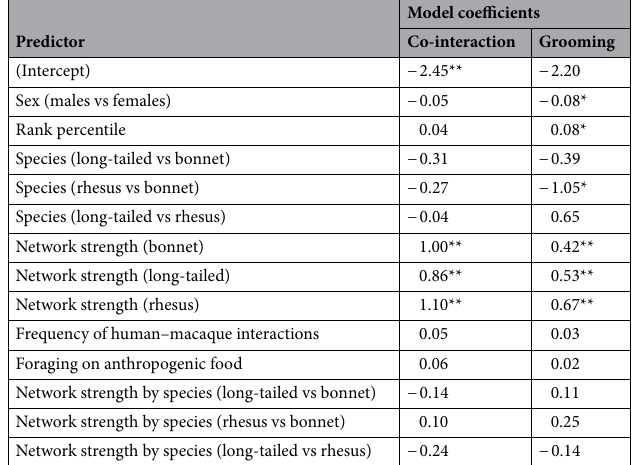
Table 2. Standardized model coefficients from the GLMMs (full model parameters in Supplementary Table 3) that examined the effects of macaque species (rhesus vs long-tailed vs bonnet), network strength centrality of the first-infected macaque, and the interaction between species and centrality, for each context. *p < 0.05; **p < 0.01.